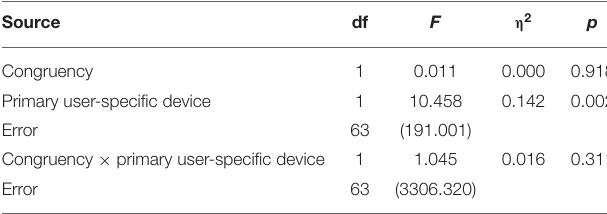
Values enclosed in parentheses represent mean square